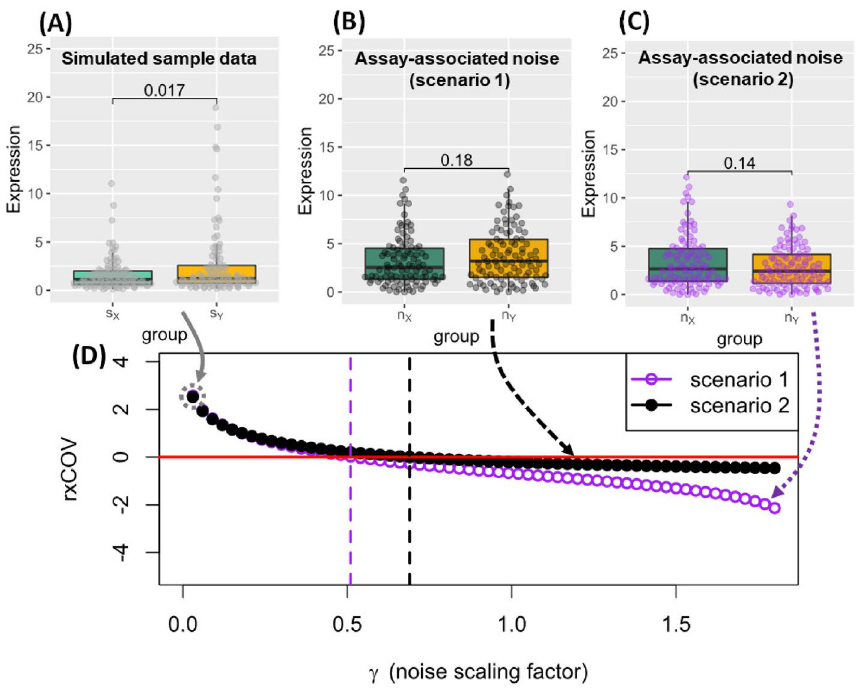
Figure 1. Simulated example of rx COV as an objective fidelity metric. ( A ) Analyte data simulating hypothetical cytokine expression in two sample groups s X and s Y . The difference in cytokine expression is significant at the 95% confidence level. ( B ) Baseline scenario 1 representing measurement noise associated with assaying each sample of each group. ( C ) Baseline scenario 2 representing a slightly different assay-associated noise distribution than scenario 1. Data d X and d Y are generated by scaling these baseline scenarios by the scaling factor γ and adding them to s X and s Y as formulated in Eq. (3). Assay-associated noise in both scenarios is not significant at the 95% confidence level and remains unaffected by the scaling factor γ . ( D ) rx COV plot as a function of γ for Scenarios 1 and 2. When γ = 0 , d X = s X and d Y = s Y , no assay noise is assumed, and the two scenarios coincide. This is indicated by the dashed gray circle. The solid red line corresponds to rx COV = 0 , the objective fidelity threshold. The purple and black dashed vertical lines correspond to the noise levels at which the rx COV plots intersect the solid red line, and indicate the low-fidelity analyte threshold for the two respective